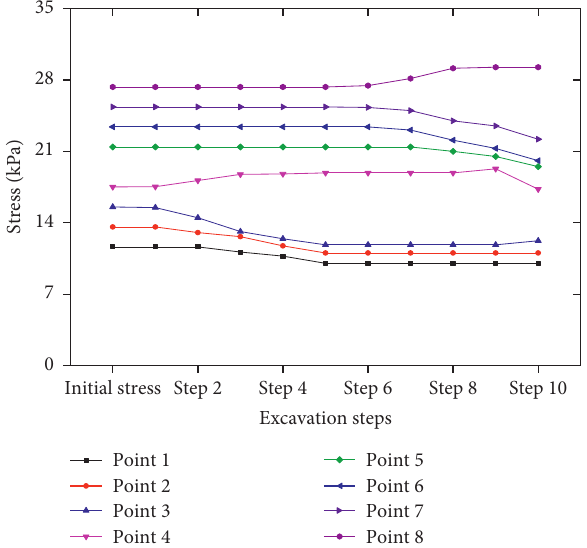
Figure 5: Stress changing of each testing point in stope roof after extraction (50 °